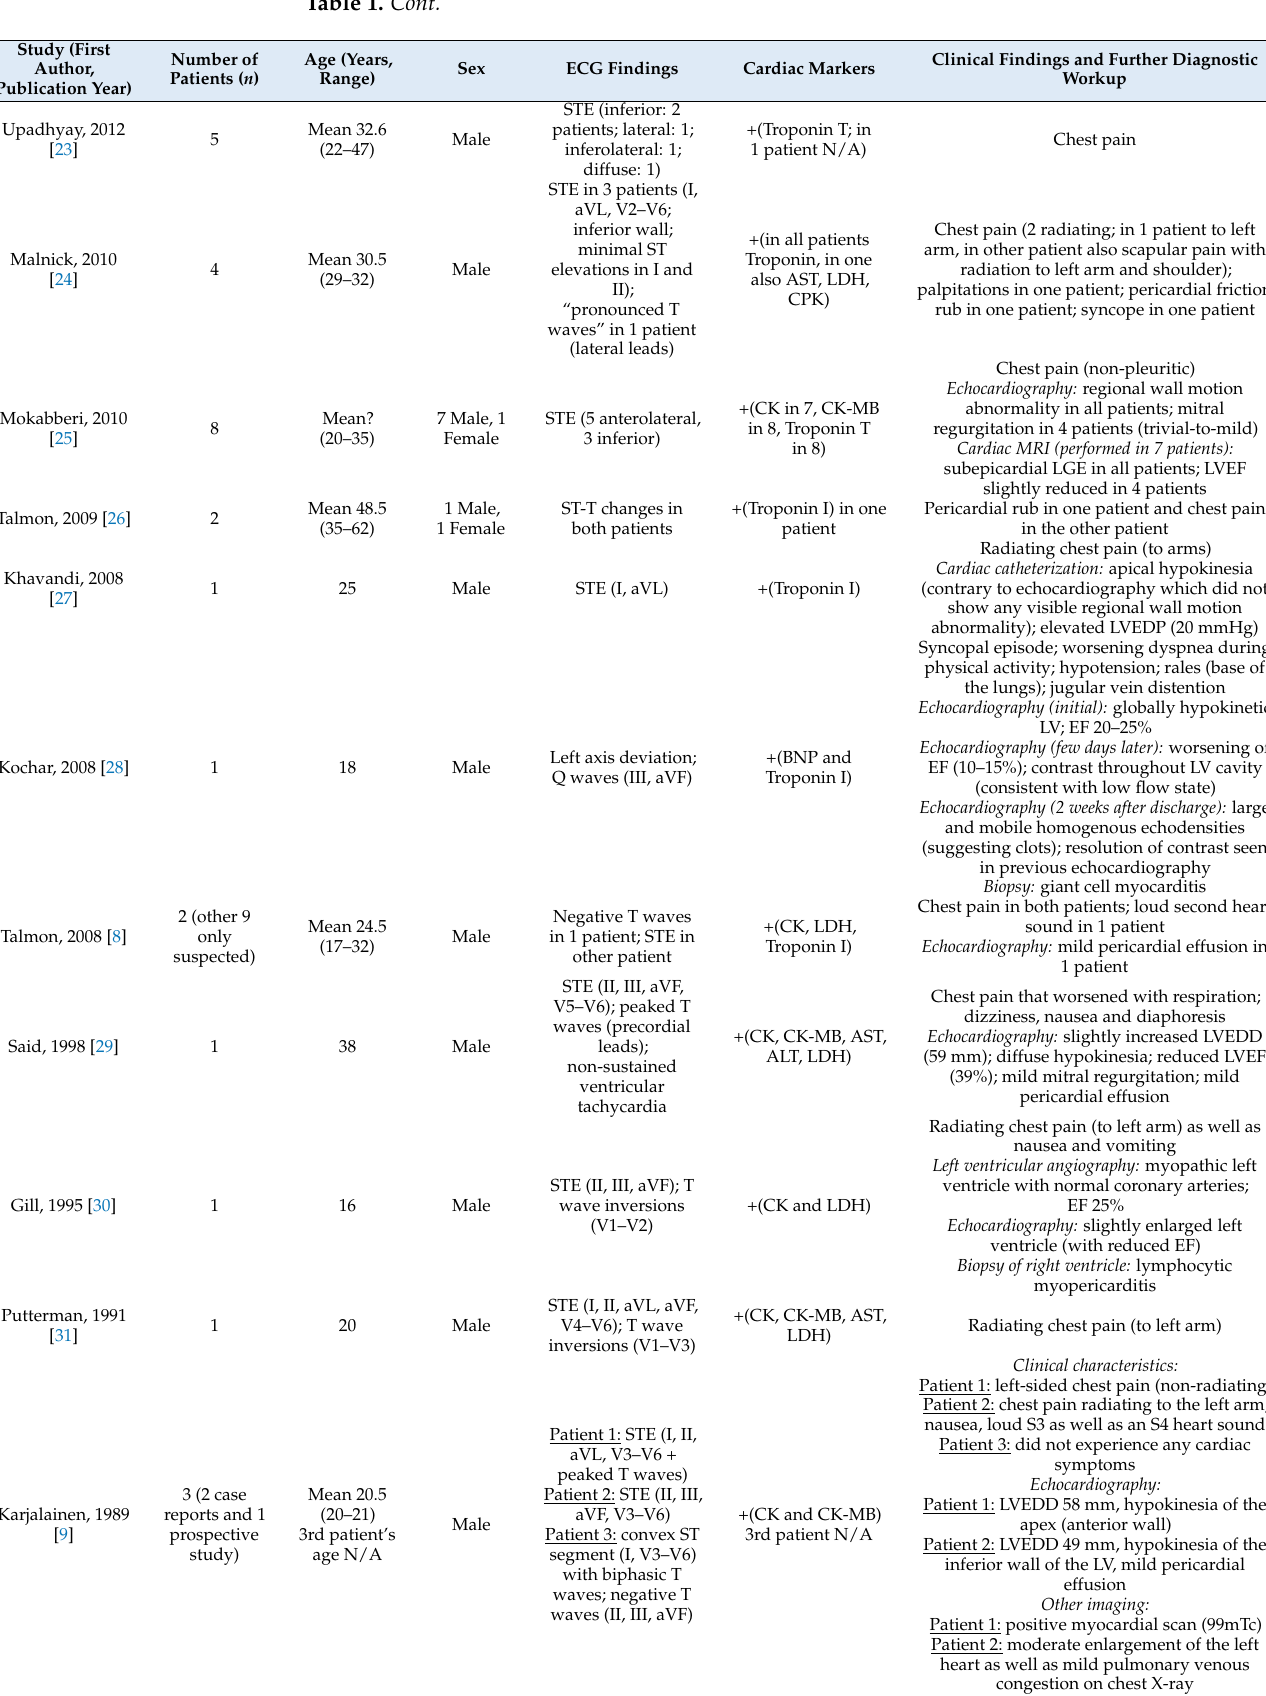
Clinical characteristics: Patient 1: left-sided chest pain (non-radiating) Patient 2: chest pain radiating to the left arm, nausea, loud S3 as well as an S4 heart sound Patient 3: did not experience any cardiac symptoms